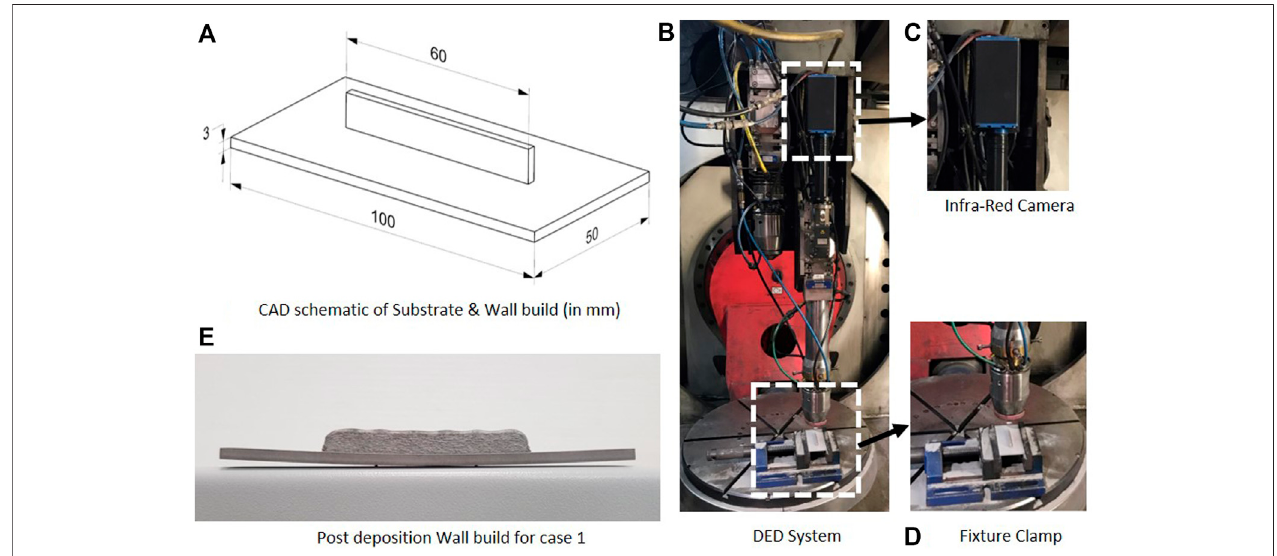
FIGURE 2 | (A) Illustrations of CAD, (B) DED system with co-axial nozzle, (C) Co-axially installed infra-red camera, (D) Fixture clamp, (E) Post deposition wall build for case.